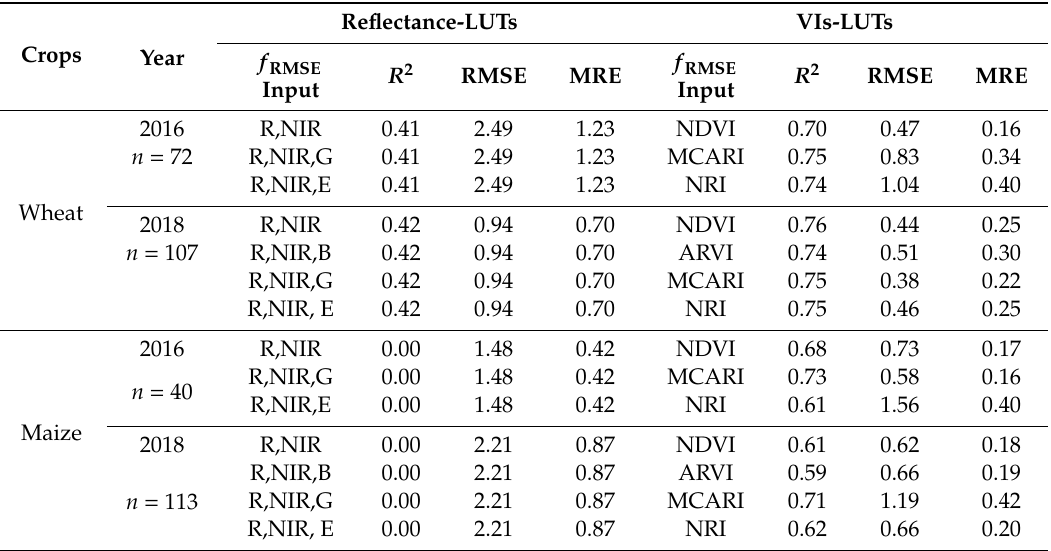
Table A1. R 2 , RMSE, and MRE for linear regression between simulated LAI and estimated LAI based on reflectance-LUTs / VI-LUTs using multispectral UAV data in 2016 and 2018.